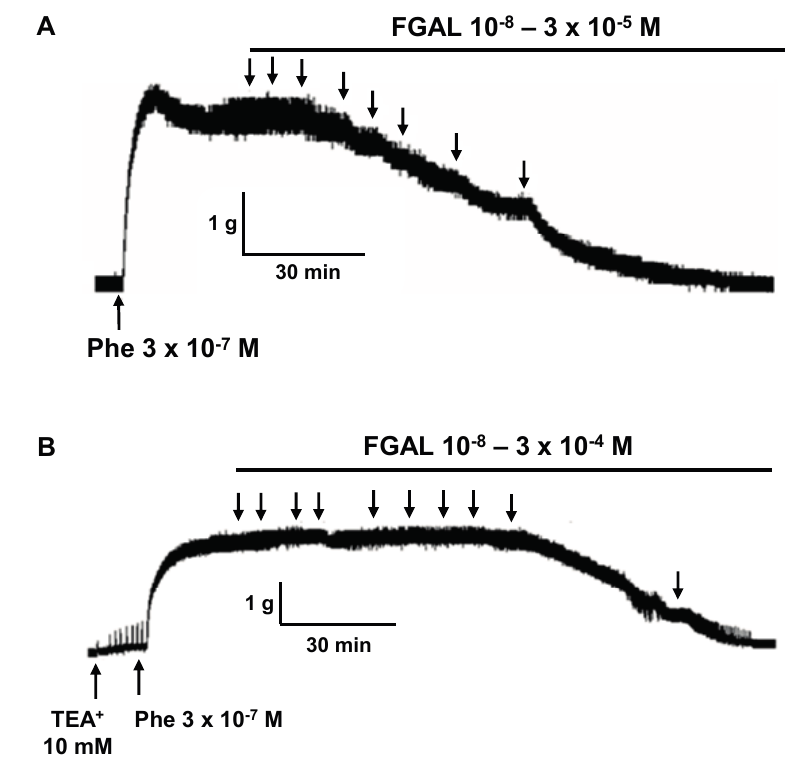
Figure 5. Representative records of relaxant effect of FGAL in rat aorta pre-contracted with 3 × 10 − 7 M Phe in both absence ( A ) and presence ( B ) of 10 mM TEA + . The arrows represent the addition of substances.